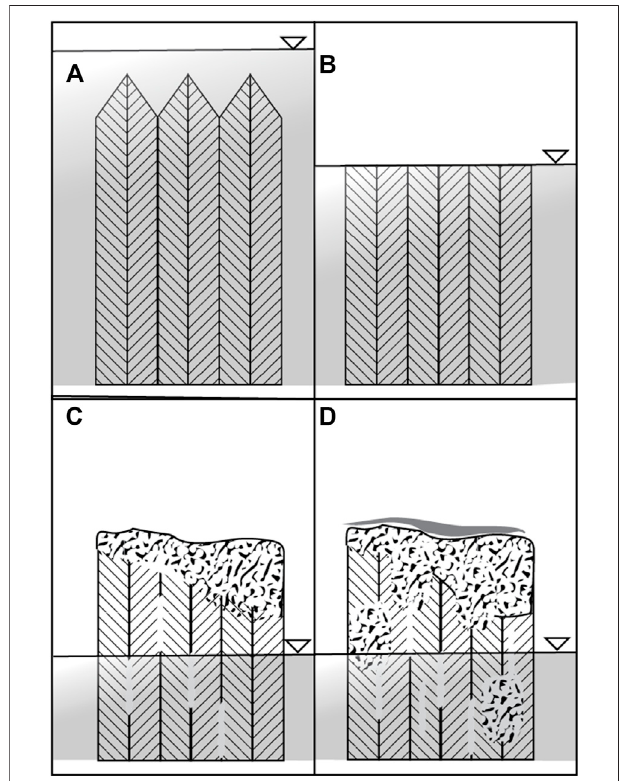
FIGURE 10 | Scenario for textural changes in gypsum at the salar surface caused by climate change, which is depicted as a change in water table elevation and the thickness of the saturated zone (shaded area). (A) Bottom-nucleated selenite forms on the bed of a shallow saline lake. (B) The surface is eroded during arid times. Changes in the water table lead to variable saturation and salt transport in vadose zone. (C) Surface crust and slot pores develop. (D) Additional alabaster zones develop further enhancing water